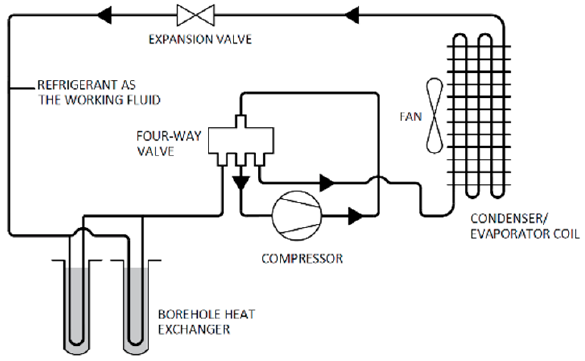
11 of 29 Figure 10. The schematic of the GCHP ( a ) with horizontal heat exchangers and ( b ) with vertical heat exchangers in heating mode. Alternatively, GHEs can also be placed vertically in boreholes at a depth of around 50 to 150 m for GCHPs (see Figure 10b). Vertical GCHPs are more feasible than horizontal in high-density housing areas because the land area needed is much less [48]. High instal- lation costs from borehole drilling can be the main obstacle for vertical GCHPs [49]. How- ever, because the ground lower than ten meters has a relatively constant temperature throughout the year, vertical GCHPs can yield a higher system performance than hori- zontal GCHPs [50]. Many studies have been conducted to investigate the effectiveness of GCHPs, exam- ining the COPs of GCHP systems with horizontal GHEs and vertical GHEs for greenhouse heating in a mild climate zone. The results indicated that the GCHP system with vertical GHEs yielded a higher COP than horizontal GHEs, but at a significantly increased cost due to drilling boreholes, which can be a disadvantage for installing vertical GHEs. To better improve the COP of horizontal GCHPs, an evaluation of the performance of GCHPs with horizontal GHEs configurations in a hot climate zone illustrated that increasing the length of GHEs can increase the heat exchange rate and the COP of systems, but its in- crease is not linear [51]. 4.3.2. Direct Expansion-Ground Source Heat Pump (DX-GSHP) In the DX-GSHP system, the refrigerant is directly pumped through the borehole heat